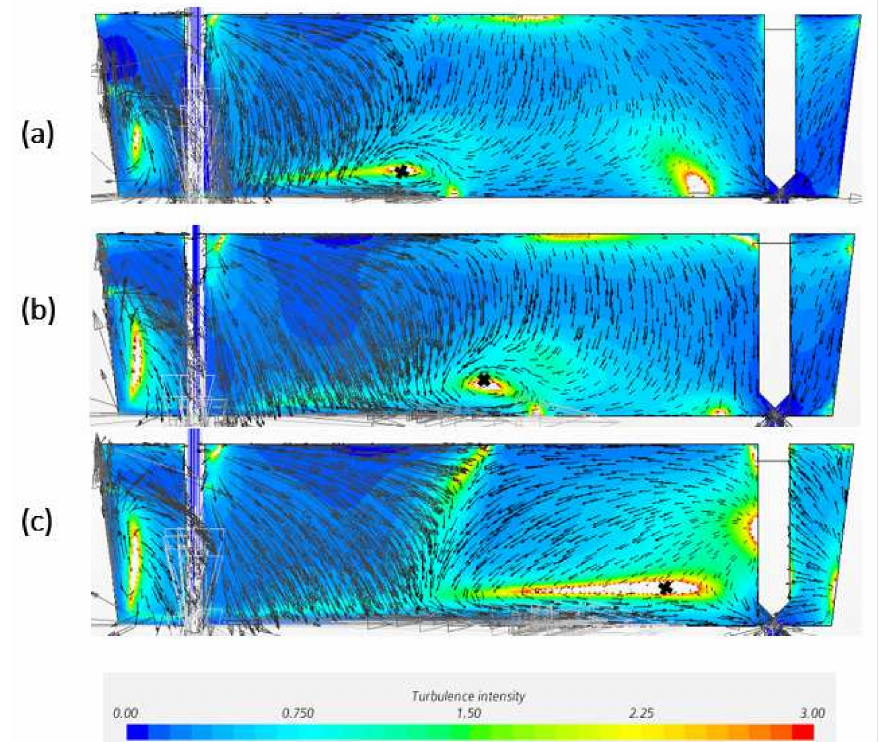
Figure 12. Velocity and turbulence intensity of water model tundish (mesh size: 0.006 m, realizable k- ε ) with ( a ) first order upwind, ( b ) second order upwind, ( c ) third order MUSCL discretization method on symmetry plane.